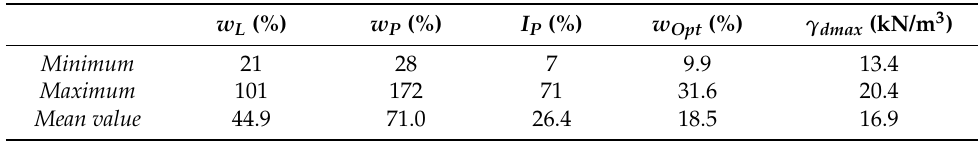
Table 1. Statistical parameters of used soils.